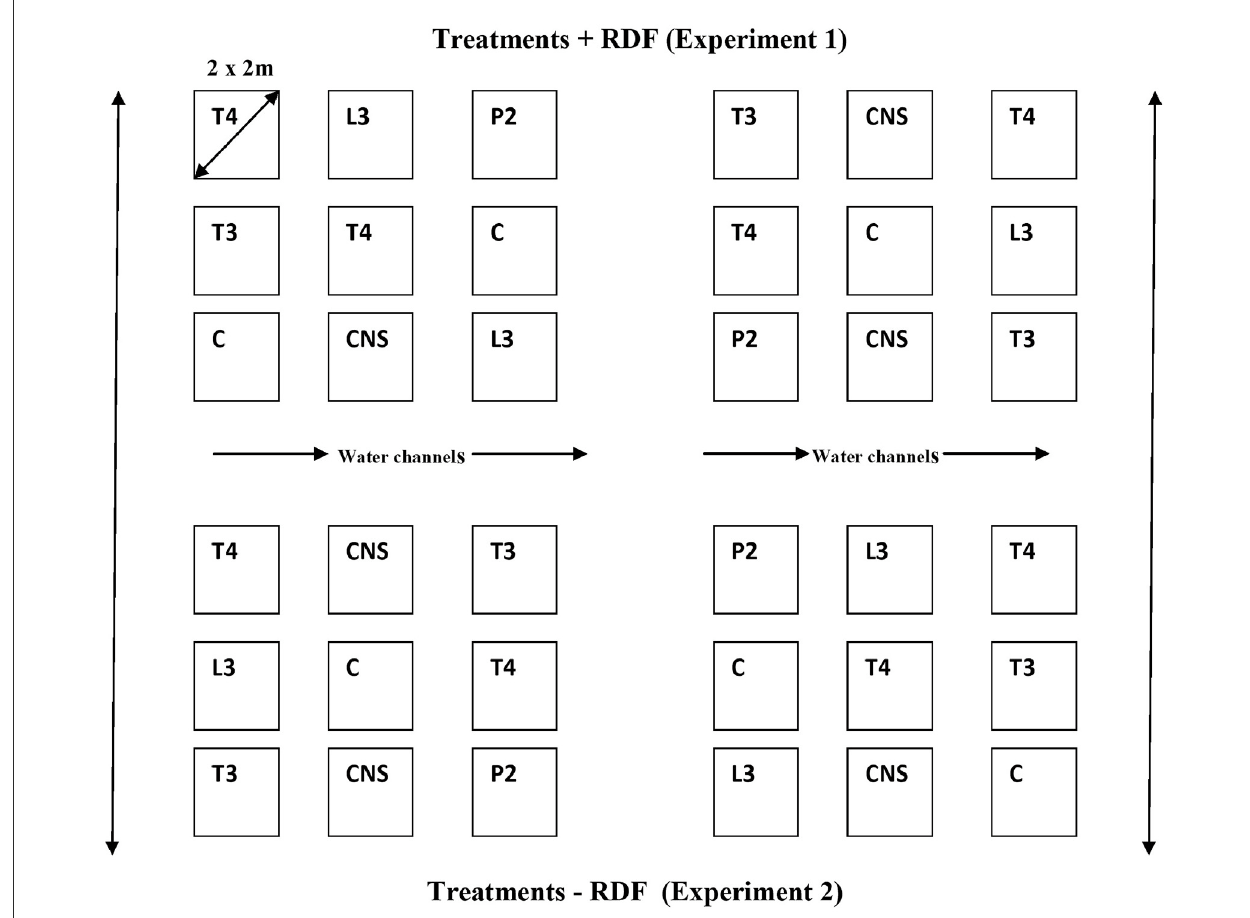
FIGURE1 The detail of treatment in the field lay out showing two experiment sets, Experiment set 1 (Treatment + RDF) and Experiment set 2 (Treatment –